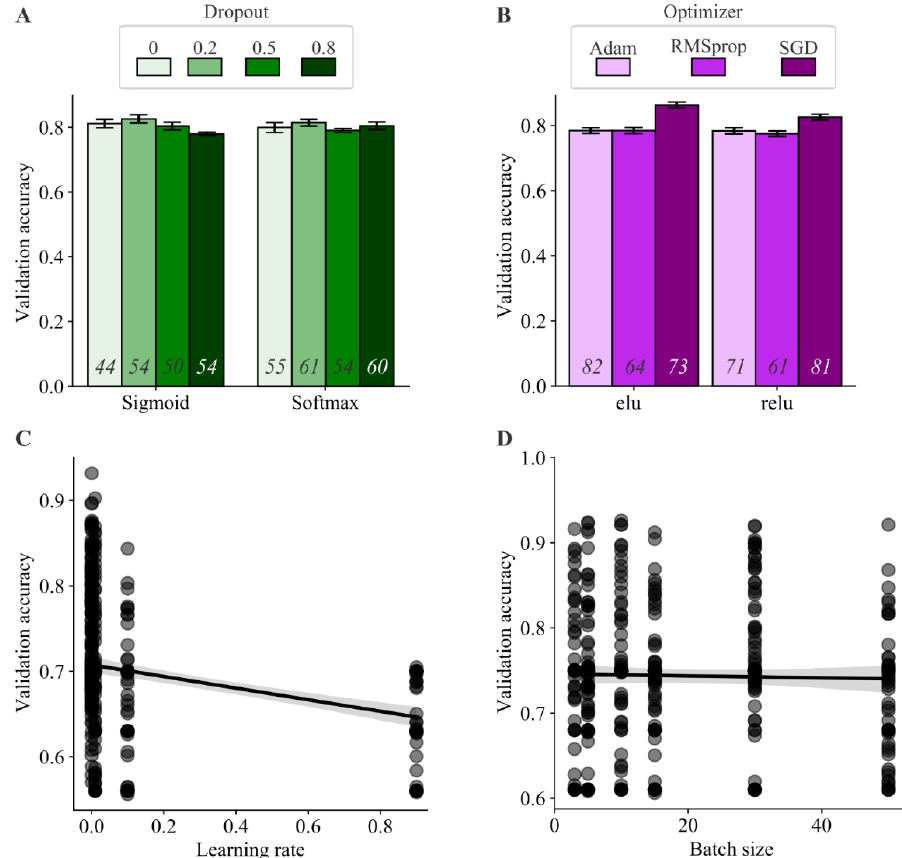
Figure A2. Hyperparameter optimization of the CNN model used in Ethoflow. ( A ) Compilation of the validation accuracy in response to the dropout and the activation function of the network output. ( B ) Validation accuracy in response to the optimizer and activation function of the inner layers. ( A , B ) The bars represent the mean ± standard error. The values at the base of each bar represent the number of times a given configuration was tested. Scatterplot of the accuracy as a function of the ( C ) learning rate and ( D ) batch size. The translucent band around the line of regression represents the confidence interval ( n = 432).